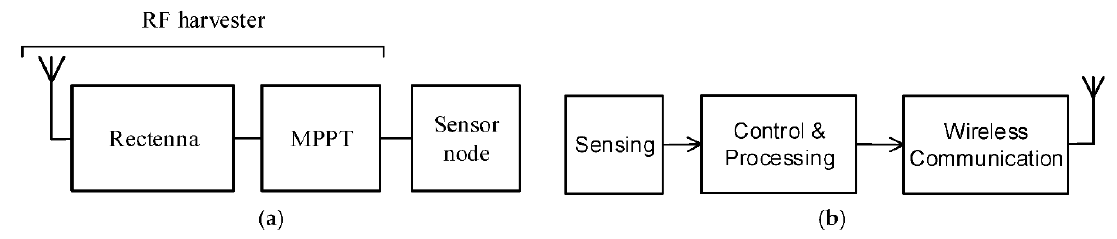
Figure 1. Generic block diagrams of: ( a ) an RF harvester; ( b ) a sensor